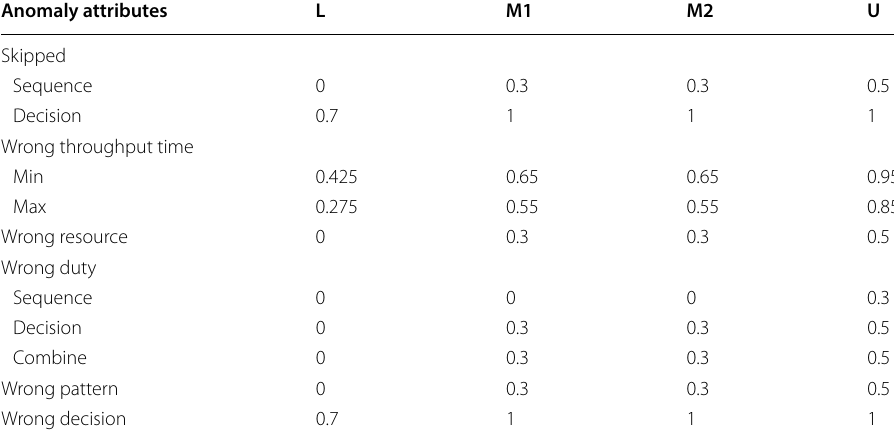
Table 3 Weights of anomaly attributes